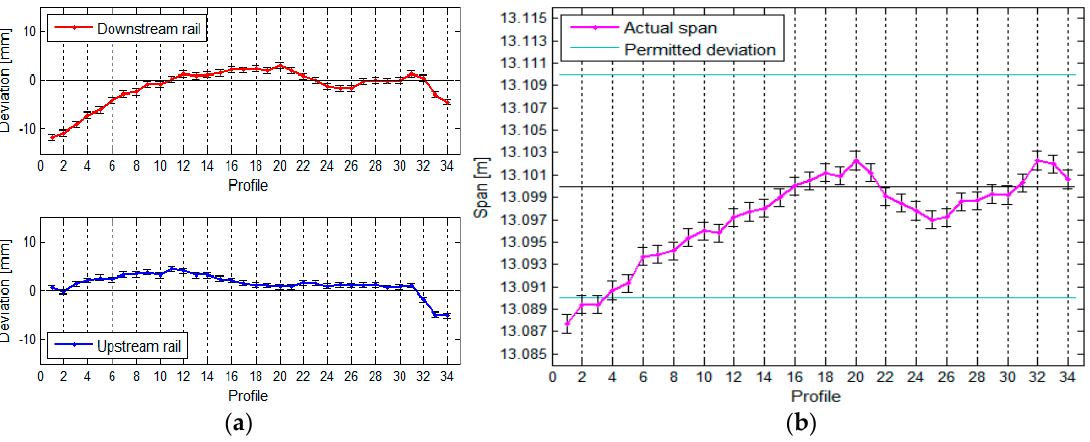
Figure 12. ( a ) The rails and their positional deviations, and ( b ) the span between the rails, with the standard deviations, for the crane in the HPP in Krško measured with TPS.